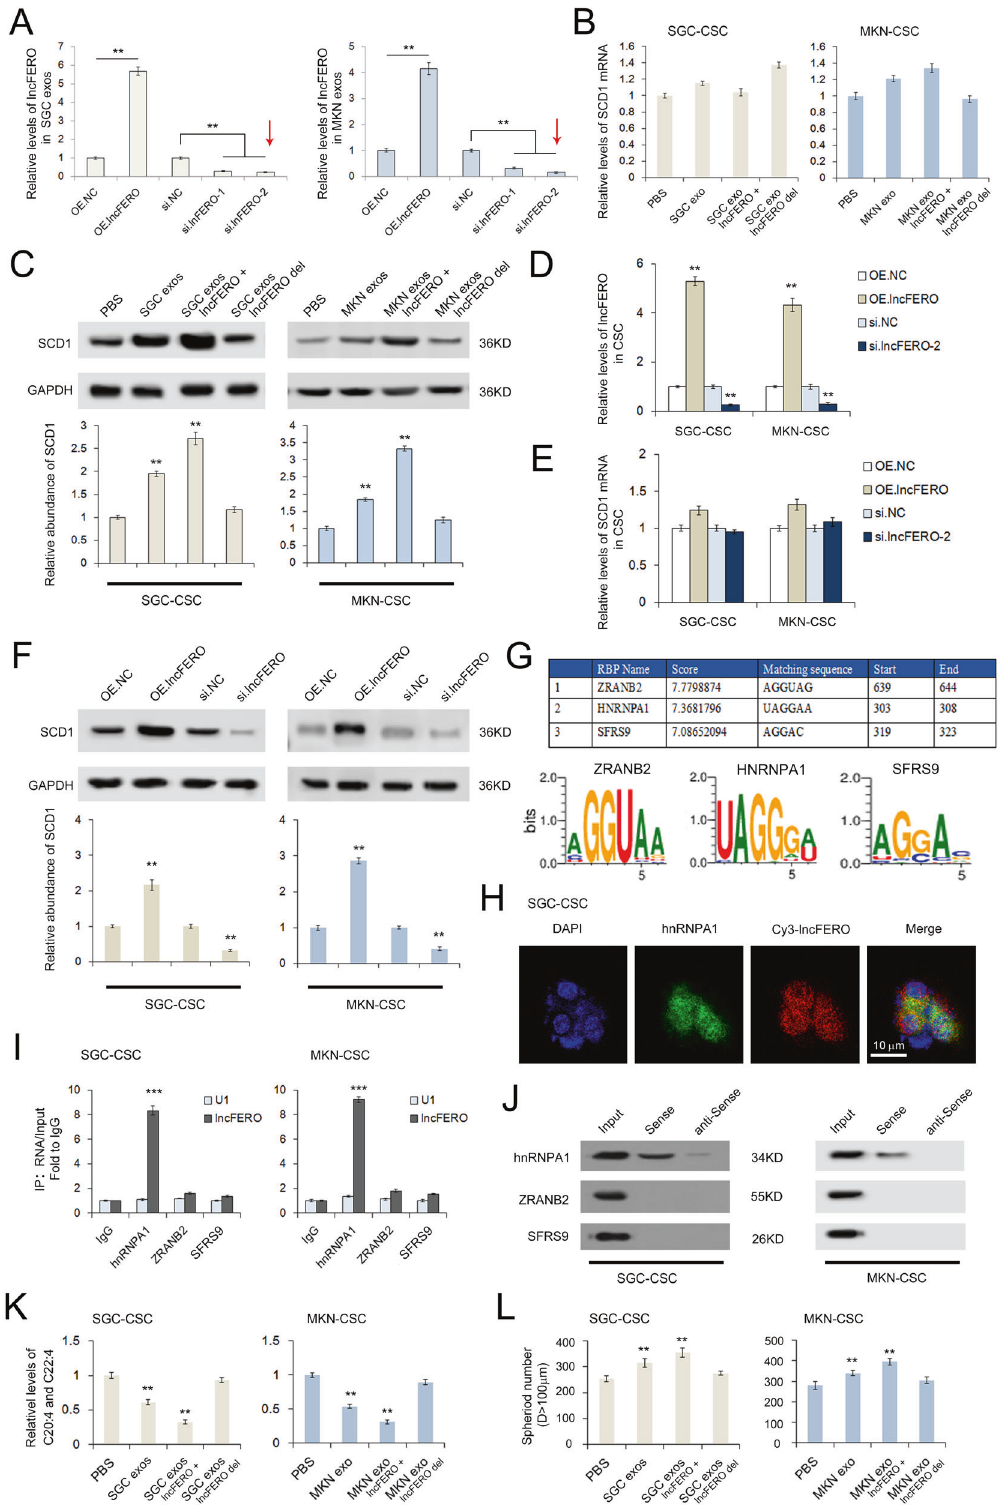
Fig. 5 LncFERO promotes SCD1 expression by recruiting hnRNPA1 in GCSCs. A Levels of lncFERO in exosomes isolated from GC cells treated with lncFERO-OE plasmids or siRNAs ( n = 3). B Effects of GC-secreted lncFERO on SCD1 mRNA levels in GCSCs ( n = 3). C Effects of GC- secreted lncFERO on SCD1 expression in GCSCs ( n = 3). D lncFERO in GCSCs was overexpressed or knocked down ( n = 3). E Effects of lncFERO on the expression of SCD1 mRNA in GCSCs ( n = 3). F Western blotting analysis of SCD1 expression in GCSCs with overexpression or knockdown of lncFERO ( n = 3). G RBPDB analysis of the speci fi c interaction between lncFERO and RBP motifs. H The colocalization of Cy3- lncFERO and hnRNPA1 in GCSCs ( n = 3). I RNA immunoprecipitation assay shows the direct interaction between lncFERO and hnRNPA1 in GCSCs ( n = 3). J Detection of hnRNPA1 protein in the samples derived from lncFERO pulldowns performed in GCSCs. K GC exosomal lncFERO decreased PUFA levels in GCSCs ( n = 3). L GC exosomal lncFERO promoted the stemness of GCSCs ( n = 3). ** p < 0.01 and *** p < 0.001. Cell Death and Disease (2021)